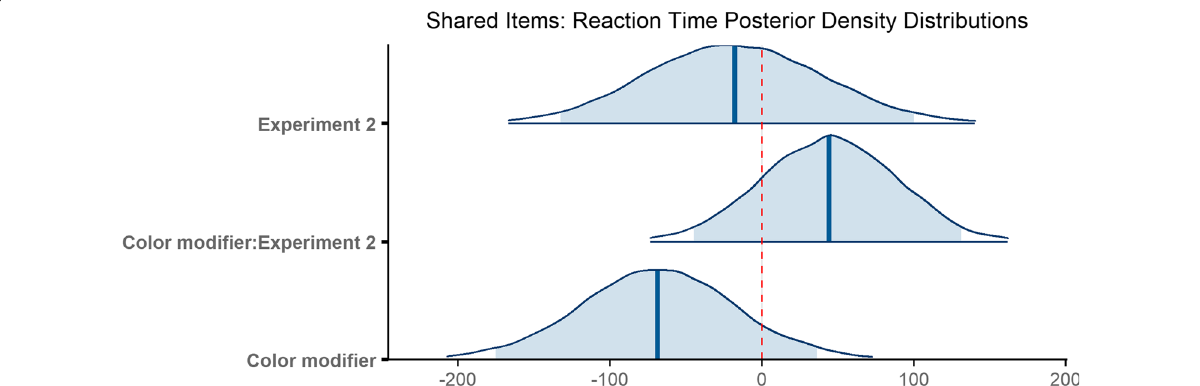
Fig. 15 Posterior density distributions for reaction time β parameter estimates for each level of the fixed effect relative to the reference level. Light blue shaded regions indicate the 95% credible interval and blue vertical lines indicate the mean of the distribution. The red vertical dashed line highlights 0 on the x axis. If the red line falls within the light blue shaded region, the estimate is not reliably different from zero and interpreted as a null